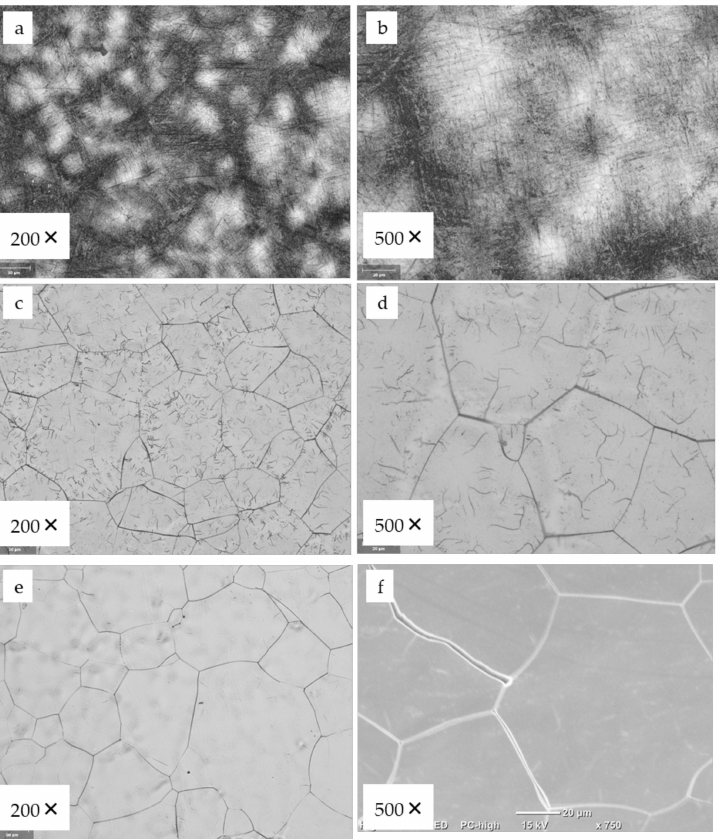
Figure 4. OM microstructure of the alloys: ( a , b ) Ti10Nb10Zr5Ta; ( c , d ) Ti20Nb20Zr4Ta; and ( e , f ) Ti29.3Nb13.6Zr1.9Fe in a cast state.